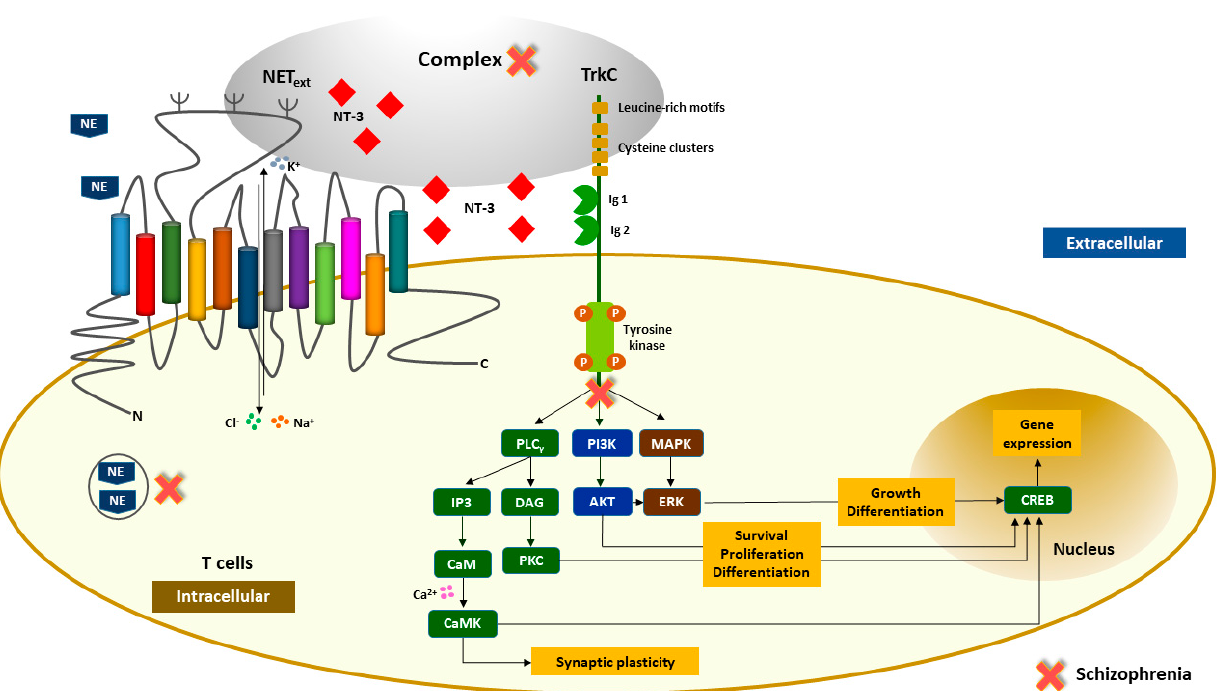
Figure 5. Schematic representation of NEText, NT-3, and TrkC distribution in T cells of patients with schizophrenia and healthy controls. Legend: NT-3-mediated signal transduction pathways through dimerization of TrkC receptors, which results in an intracellular activation of extracellular signal-regulated kinases (ERKs), phosphatidylinositol-3-kinase (PI3K)-protein kinase B (AKT), and phospholipase C- γ (PLC γ ) pathways promoting cell survival, proliferation, differentiation, synaptic plasticity, and gene expression in T cells. The molecular complex between the second extracellular loop of NEText (corresponding to amino acid residues 189–204) and NT-3 or TrkC seems to be essential for appropriate activation of the signaling cascade in a peripheric context that involves immune system cells. The red cross represents the mechanisms/pathways that are disrupted in schizophrenia.